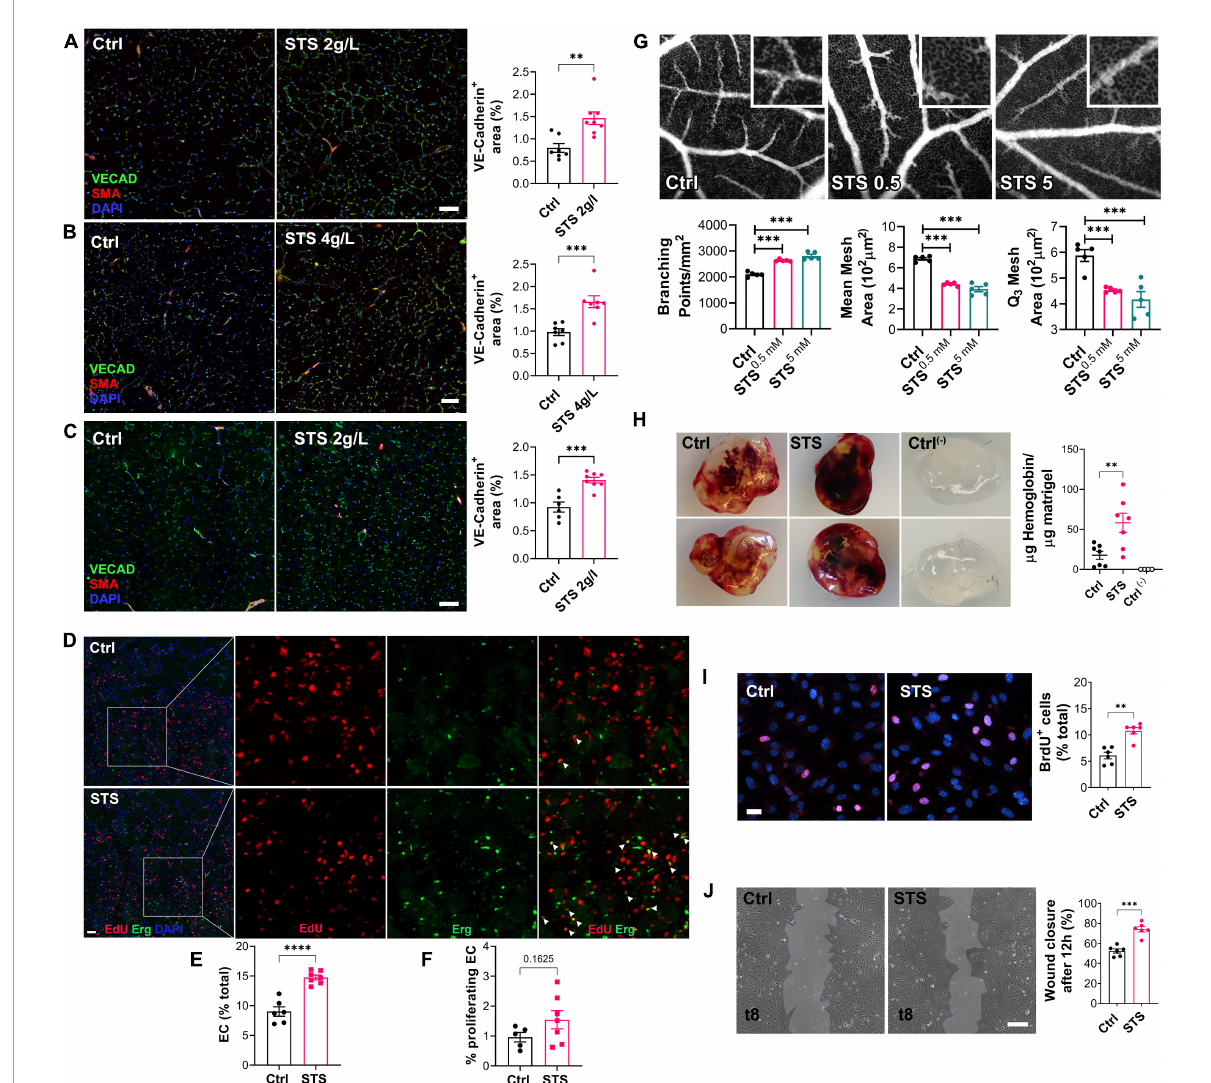
FIGURE3 Sodium thiosulfate (STS) promotes angiogenesis in vivo in several models. (A–C) VE-cadherin (VECAD; green), smooth muscle actin (SMA; red) and nuclei (DAPI; blue) immunostaining in gastrocnemius muscle from WT male mice submitted to HLI and treated or not (Ctrl) with 2 g/L STS (A) or 4 g/L STS (B) , or LDLR - / - mice treated with 2 g/L STS (C) . Representative images and quantification of the VECAD staining in 6–9 animals per group. Data are mean ± SEM. ** p < 0.01, *** p < 0.001 as determined by bilateral unpaired t -test. (D) EdU (red), ERG (green) and nuclei (blue) immunostaining in ischemic muscle of WT mice treated with 2 g/L STS 4 days after HLI. Scale bar represent 100 µ m. Insets are 3-fold magnification of left images. (E) Percentage of endothelial cells (ERG+/total nuclei count). (F) Percentage of proliferating endothelial cells (EdU+/ERG+). Data are mean ± SEM. * p < 0.05, **** p < 0.0001 as determined by bilateral unpaired t -test. (G) Representative fluorescein-dextran fluorescence angiographies at EDD13, 48 h after topical treatment with 0.9% NaCl (Ctrl), or STS (0.5 or 5 mM